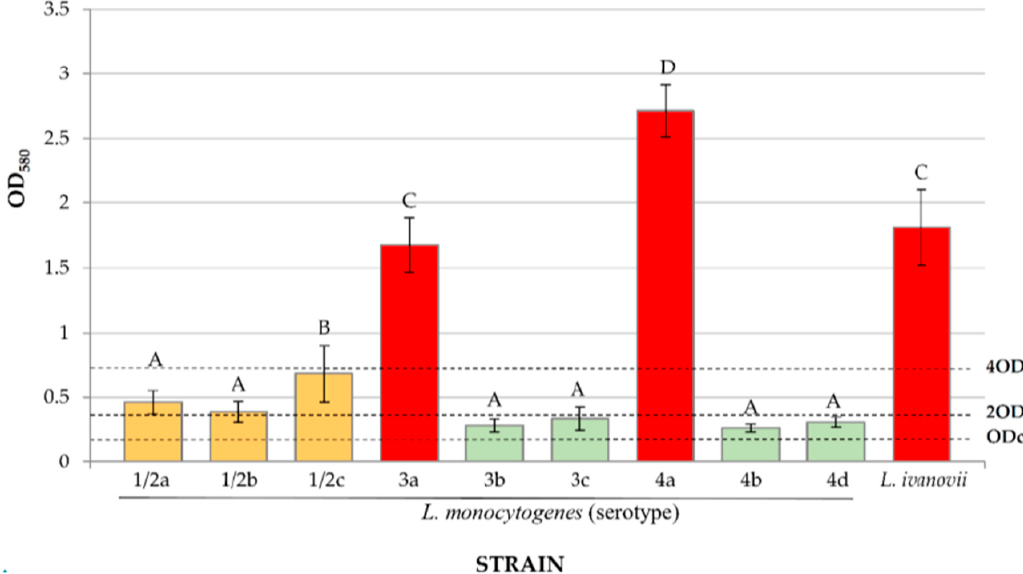
Figure 4. Biofilm formation by various strains of Listeria spp. on polystyrene after 24 h of incubation at 37 °C (crystal violet staining technique; optical density at 580 nm). Averages (mean ± standard deviation; n = 6) with no letters in common are significantly different ( p < 0.05). Strong producers of biofilm (OD > 4ODc); moderate producers of biofilm (2ODc < OD ≤ 4ODc); weak producers of biofilm (ODc < OD ≤ 2ODc).